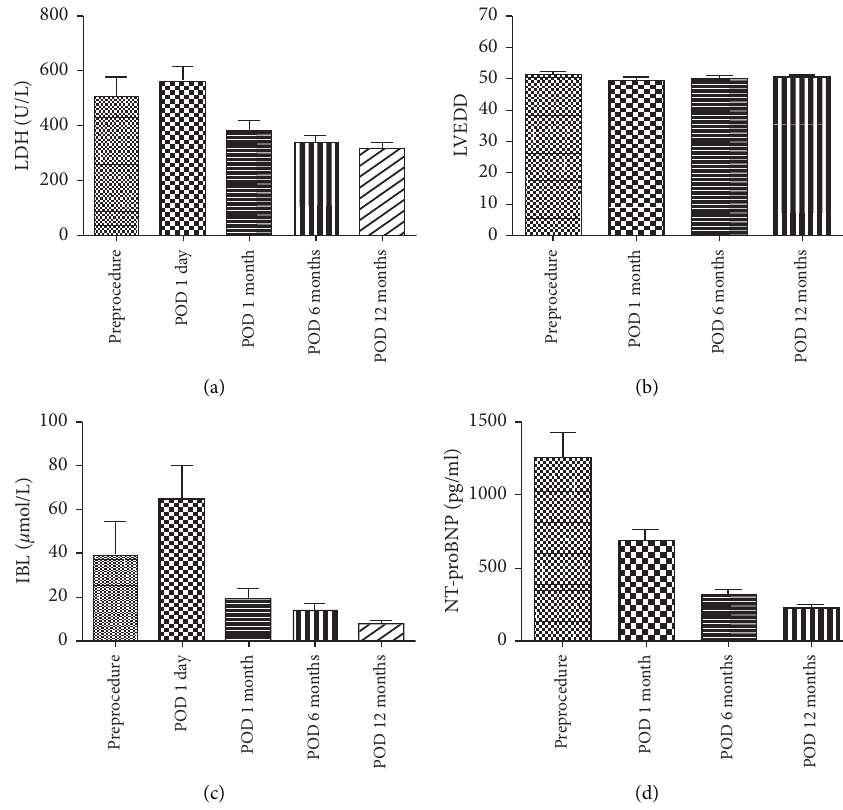
Figure 6: The 1-year follow-up results.